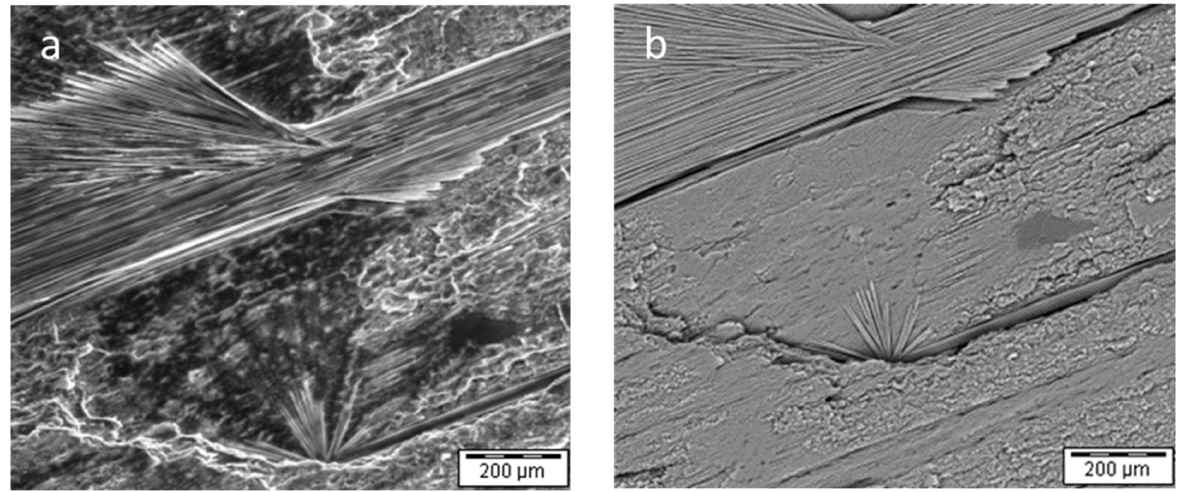
Figure 6. ( a , b ) Gypsum crystal cleaved along the cleavage plane after dehydration 4 h at 140 °C, SEM, low-vac mode.